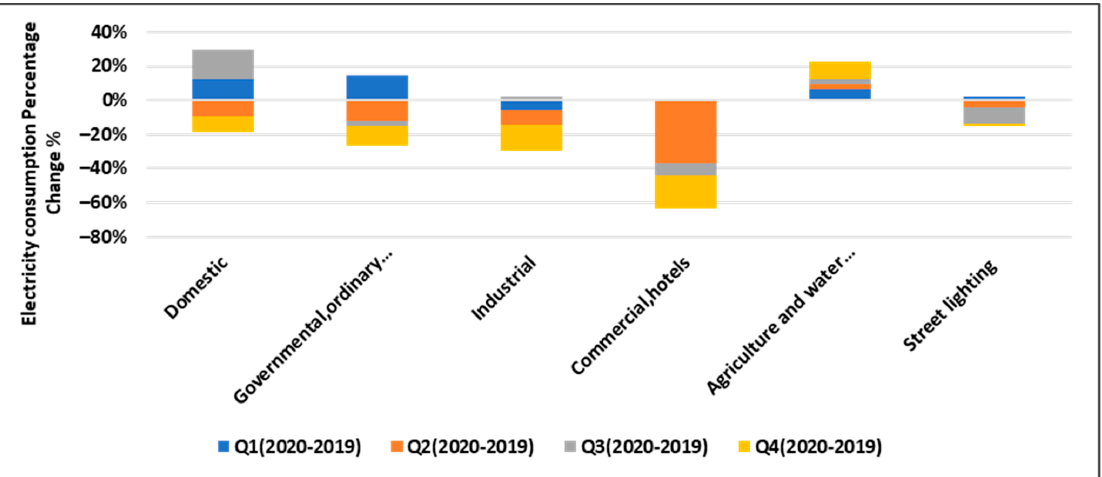
Figure 19. Change in electricity consumption in EDCO’s region by quarter between 2019 and 2020.